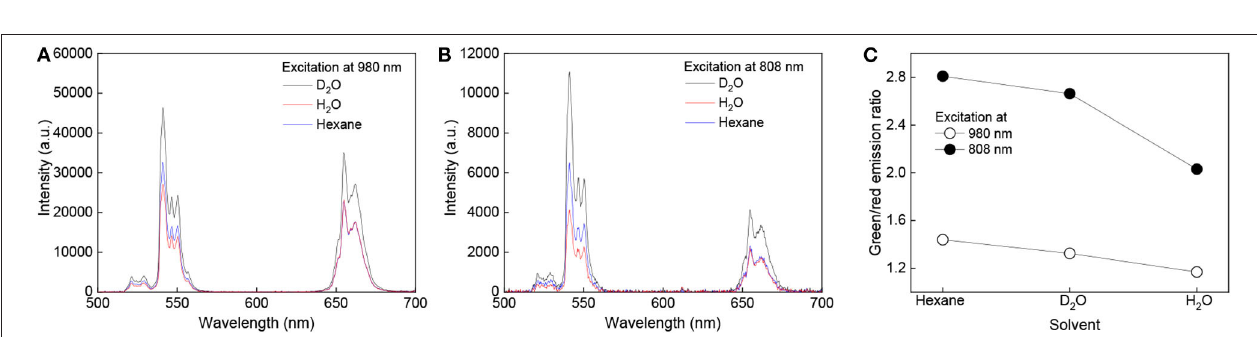
FIGURE 6 | Photoluminescence upconversion spectra of NaYF 4 :Yb 3 + /Er 3 + @NaYF 4 :Nd 3 + (0.7 mmol) core-shell nanoparticles (1 mg/ml) in D 2 O (black), water (red), and hexane (blue) at (A) 808 and (B) 980nm excitation. (C) Green-to-red emission intensity ratio for different solvents; average power density of both lasers ∼ 30 W/cm 2